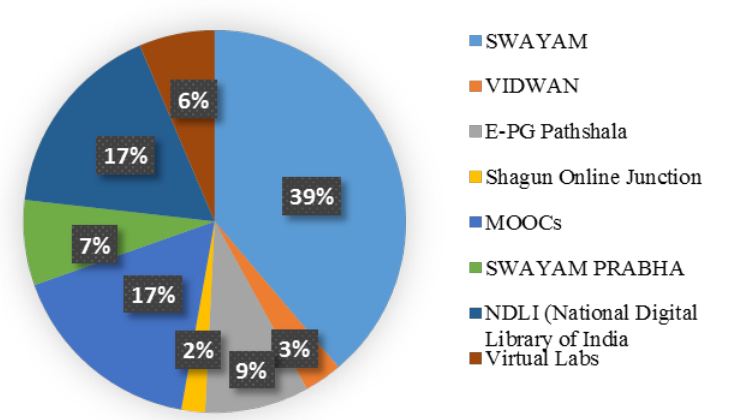
Figure - 6: Showing the most useful online learning platform for the learning